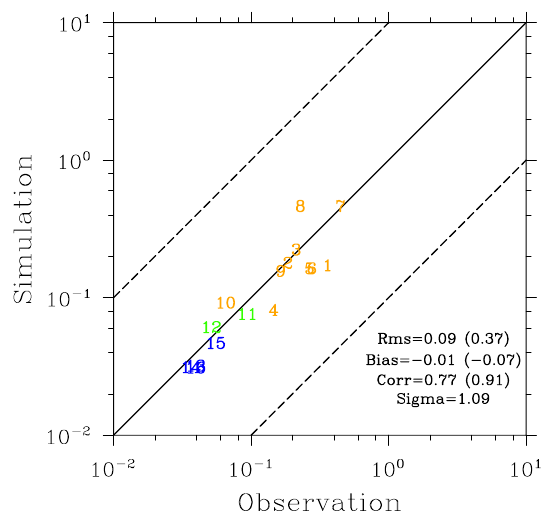
Fig. 7. Comparison of surface dust concentration (mgm − 3 ) be- tween CanAM4-PAM simulation and visibility-based estimates from measurements in Asia. Model results are averaged over MAM in 2000 and 2001. Stations are grouped according to the country as shown in Fig. 6: China (orange), South Korea (green) and Japan (blue). Locations of each station are listed in Table 5. Root mean square error (Rms), bias, correlation (Corr) and ratio of modelled to observed standard deviation (sigma) are indicated. Normalized root mean square error and mean normalized bias are given in the parenthesis next to Rms and Bias. The correlation with respect to the logarithm of the model results and of the observation is given in the parenthesis next to Corr. Black solid line is the 1 : 1 line and black dash lines are 10 : 1 and 1 : 10